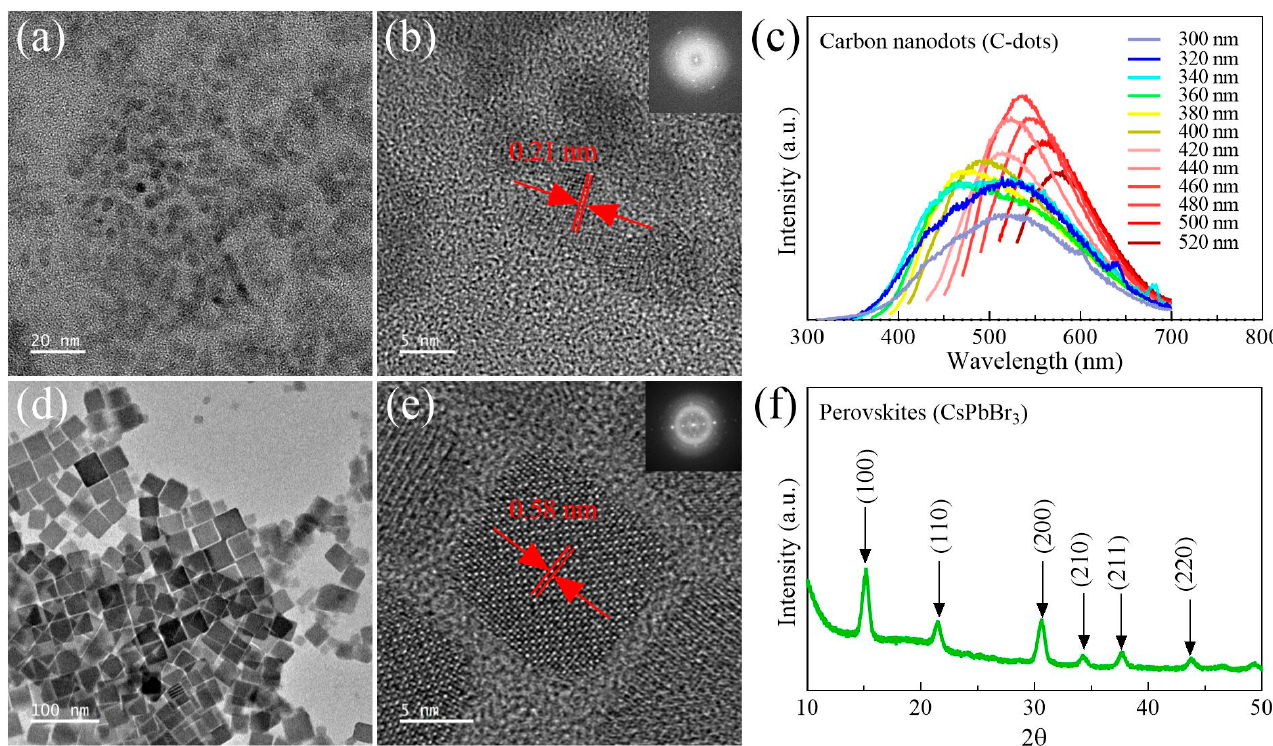
Figure 2. ( a ) Low-magnification TEM image of carbon nanodots. ( b ) High-resolution TEM image of typical C-dots. ( c ) PL spectra of C-dots under different excitation wavelengths. ( d ) TEM image of the CsPbBr 3 perovskite. ( e ) High-resolution TEM image of typical CsPbBr 3 perovskite nanocrystals. ( f ) XRD pattern of the perovskite layer.